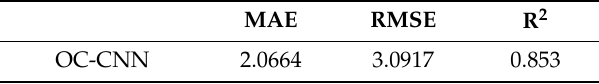
Table 2. The MAEs, MREs, and R 2 of OC-CNN in hotspot areas.